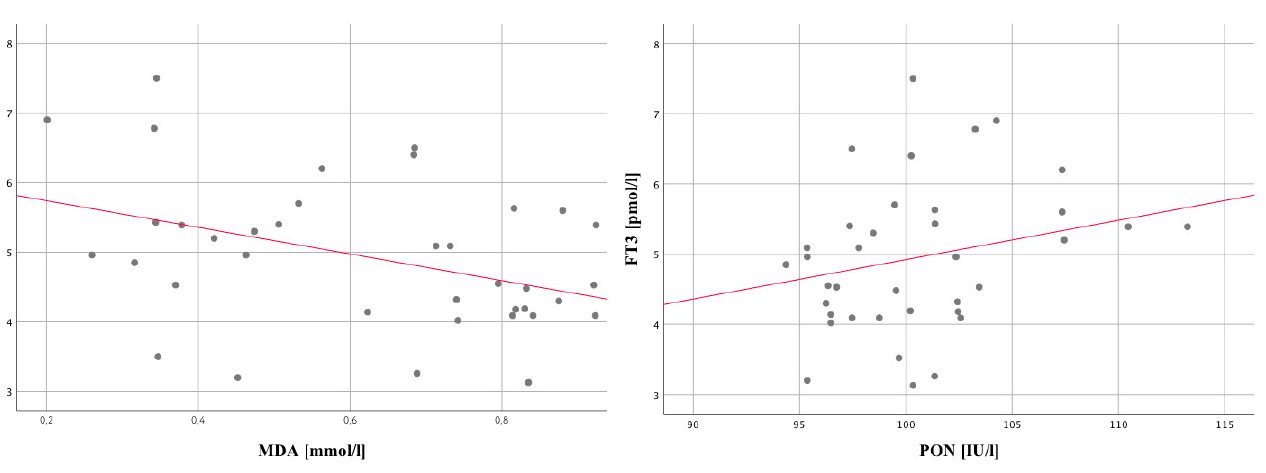
Figure 1. Relationship between FT3 and MDA/PON, respectively.